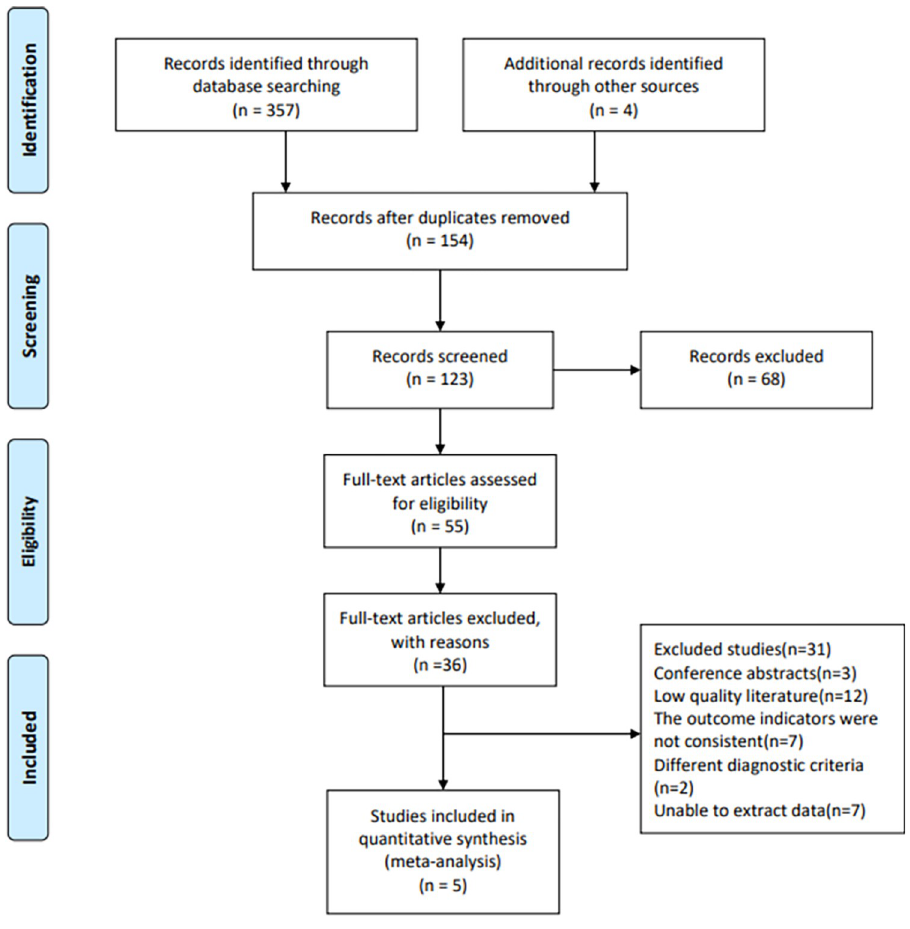
Fig 1. Flow diagram based on the Preferred Reporting Items for Systematic Reviews and Meta-Analyses (PRISMA) statement.